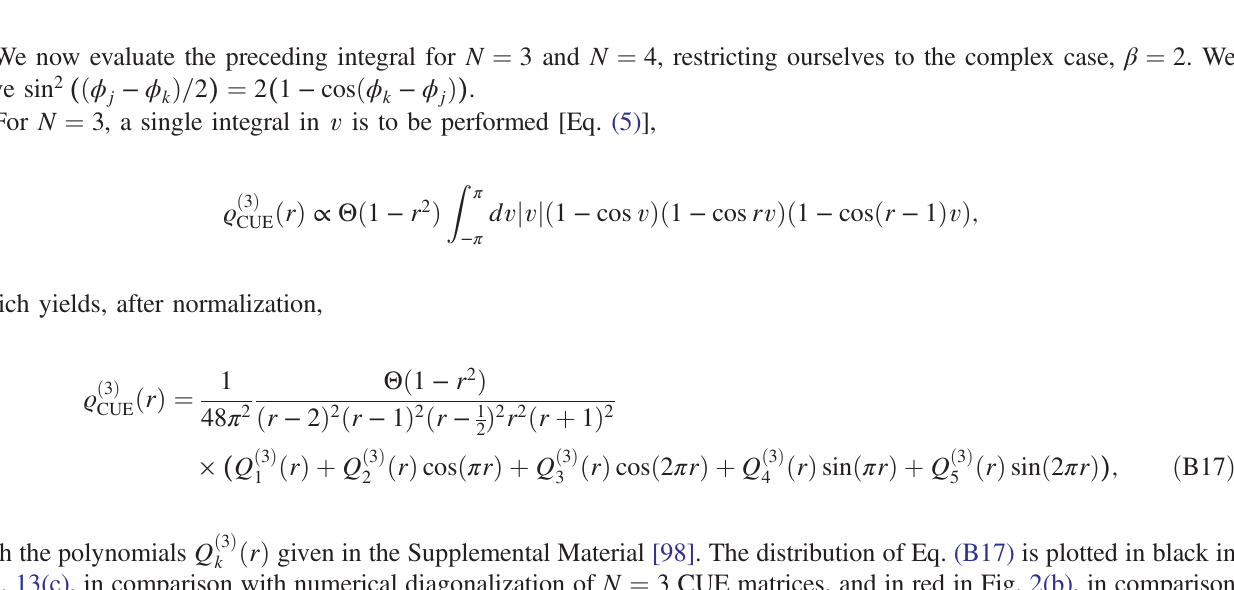
Fig. 13(c), in comparison with numerical diagonalization of N ¼ 3 CUE matrices, and in red in Fig. 2(b), in comparison with diagonalization of large- N GUE matrices.